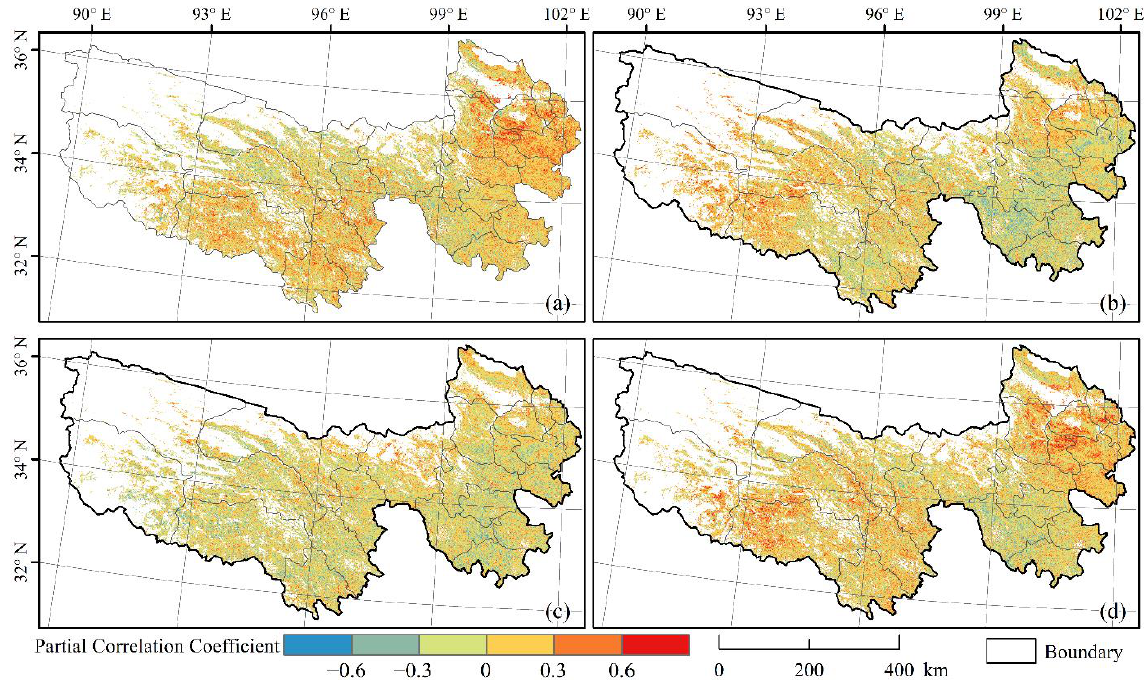
Figure 16. Spatial distribution of the partial correlation coefficients between the EOS of the vegetation and precipitation in August ( a ), September ( b ), October ( c ) and August–October ( d ) in the Three-River headwaters region.